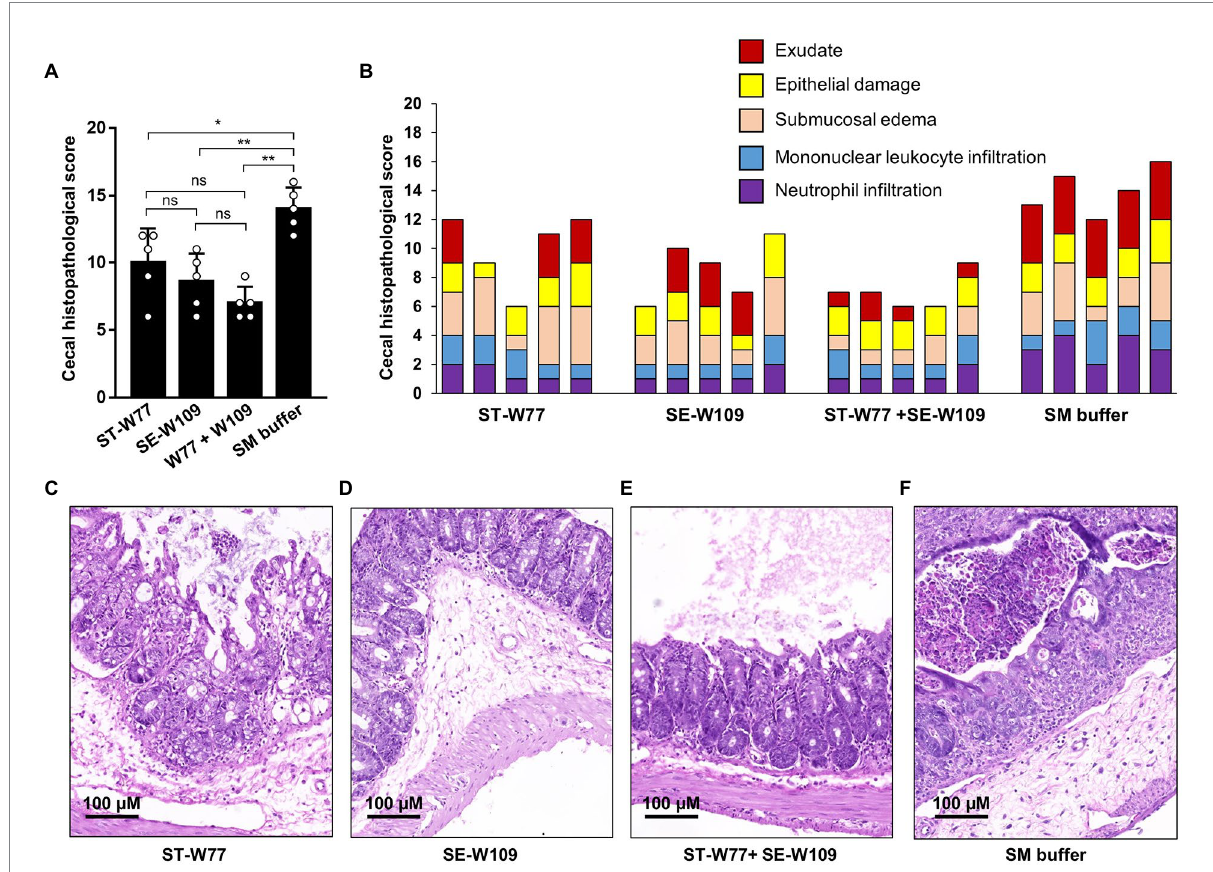
FIGURE 7 A significantly lower cecal histopathological score of S. Tm-infected mice orally treated with phages ST-W77 and SE-W109. Tips of mouse ceca were collected in 10% formalin and then hematoxylin–eosin (H&E) stained and double-blind scored by a veterinary pathologist using a histopathological score in Supplementary Table S3. The combined histopathological score (A) and the individual score with each criterion (B) . The representative picture of mouse cecum treated with ST-W77 (C) , SE-W109 (D) , combined ST-W77 and SE-W109 (E) , and SM buffer (F) . Bars represent the mean; error bars indicate standard deviation. * and **indicated p < 0.05 and 0.01, respectively. ns, a non-statistically significant